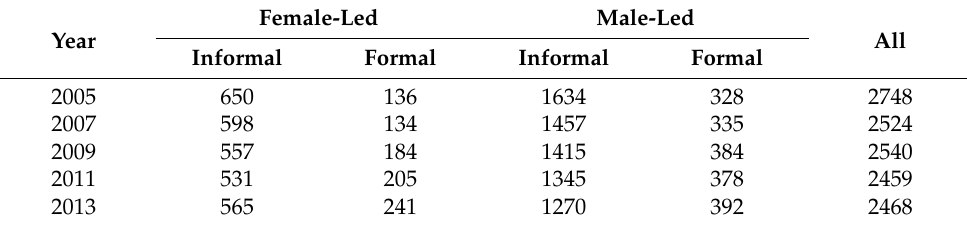
Table 1. Distribution of male-led and female-led firms in formal and informal